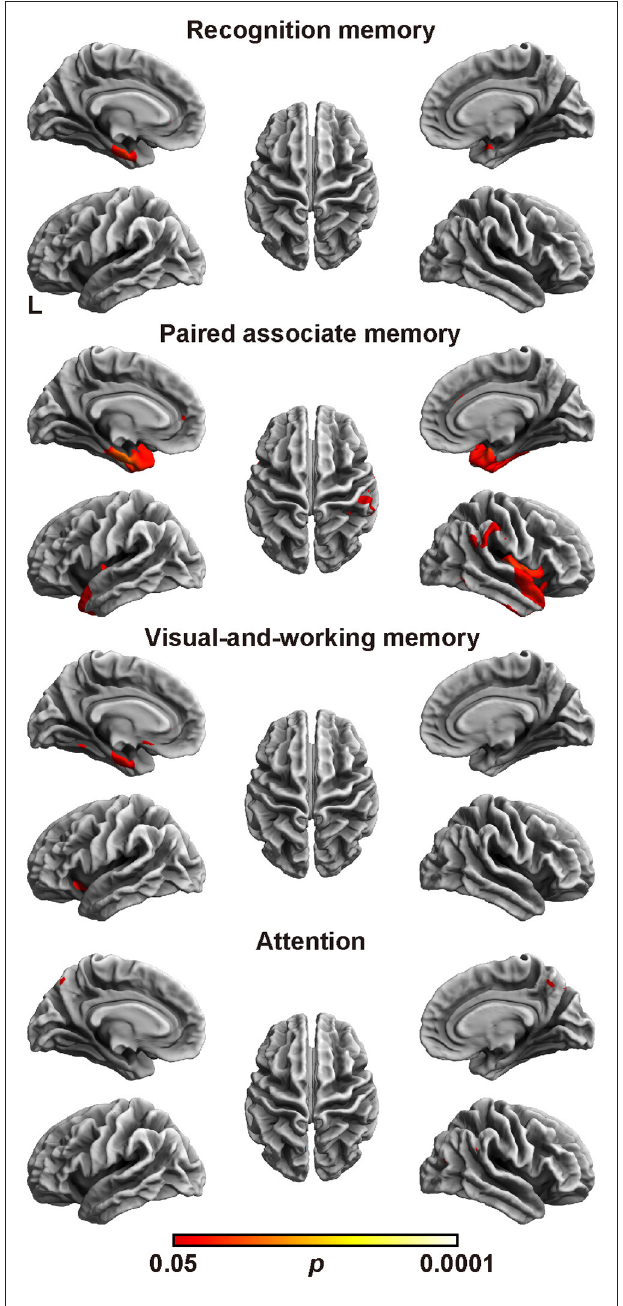
FIGURE 1 | Brain regions with a positive correlation between cortical thickness and factor scores. Significant regions are identified by surface-based morphometry, which were projected onto the left and right lateral surfaces of the standard inflated brain. Medial sections are also shown. The threshold was set at p < 0.05 (TFCE-corrected permutation test). See Table 5 for the details of the regions. L,